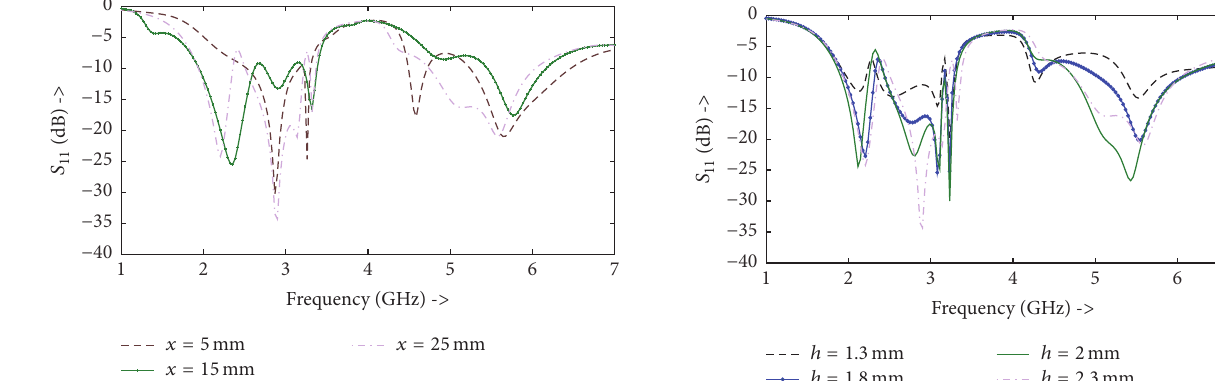
Figure 11: Reflection coefficient of different PIFA